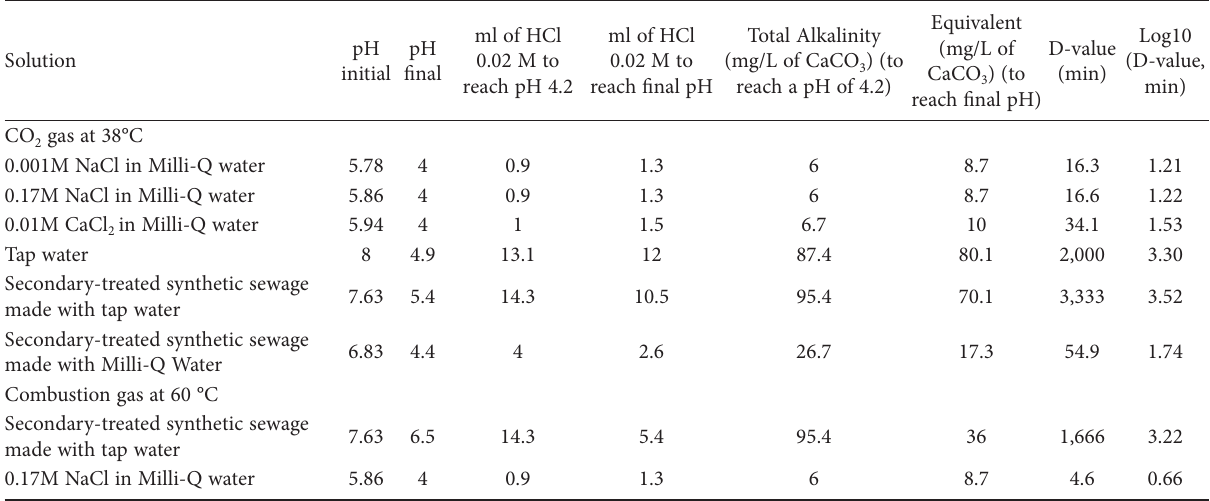
Table 1. Initial and fi nal pH values aft er bubbling CO 2 and combustion gas in 6 diff erent solutions, amount of 0.02 M HCl to reduce the pH of the solutions to 4.2, alkalinity in mg/L of CaCO 3 and D-values.